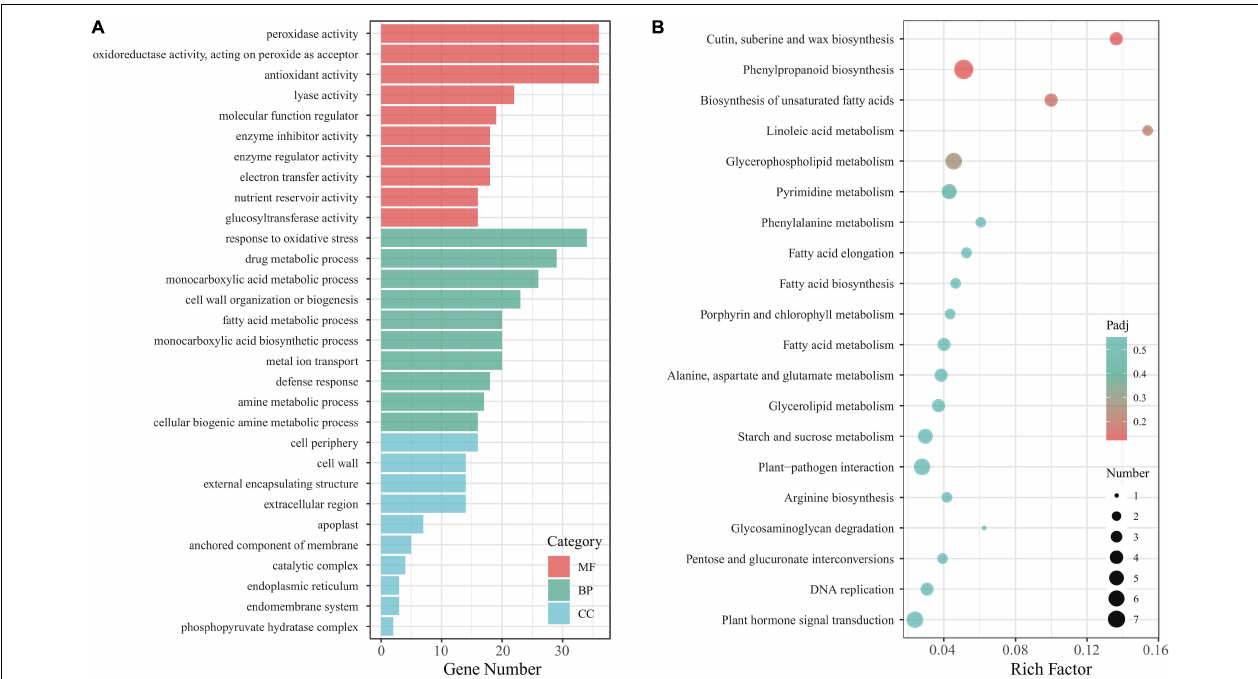
FIGURE 6 | Function analysis of DEGs in leaf sheaths of EsMYB90 transgenic wheat compared with wild type subjected to 200 mM NaCl treatment. (A) Histogram analysis of GO terms. MF, molecular function; BP, biological process; CC, cellular component. (B) Analysis of top 20 KEGG pathways. The rich factor is the ratio of the DEGs numbers to the total of annotated genes in a certain pathway. In a specific KEGG pathway, the color of dots represents the significance of DEGs, and the size of dots indicates the number of DEGs. Padj indicates the significance of the enriched DEGs, and the smaller padj value indicates higher